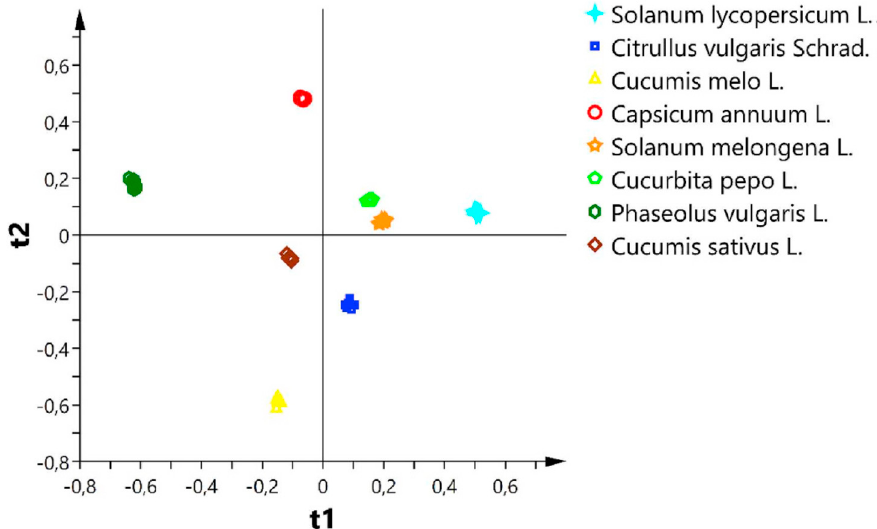
Figure 8. Partial least square-discriminant analysis (PLS-DA) scores plot derived from 80 1 H nuclear magnetic resonance (NMR) spectra for the eight different crop residue plant species evaluated. Reproduced with permission from [139], Elsevier 2019.